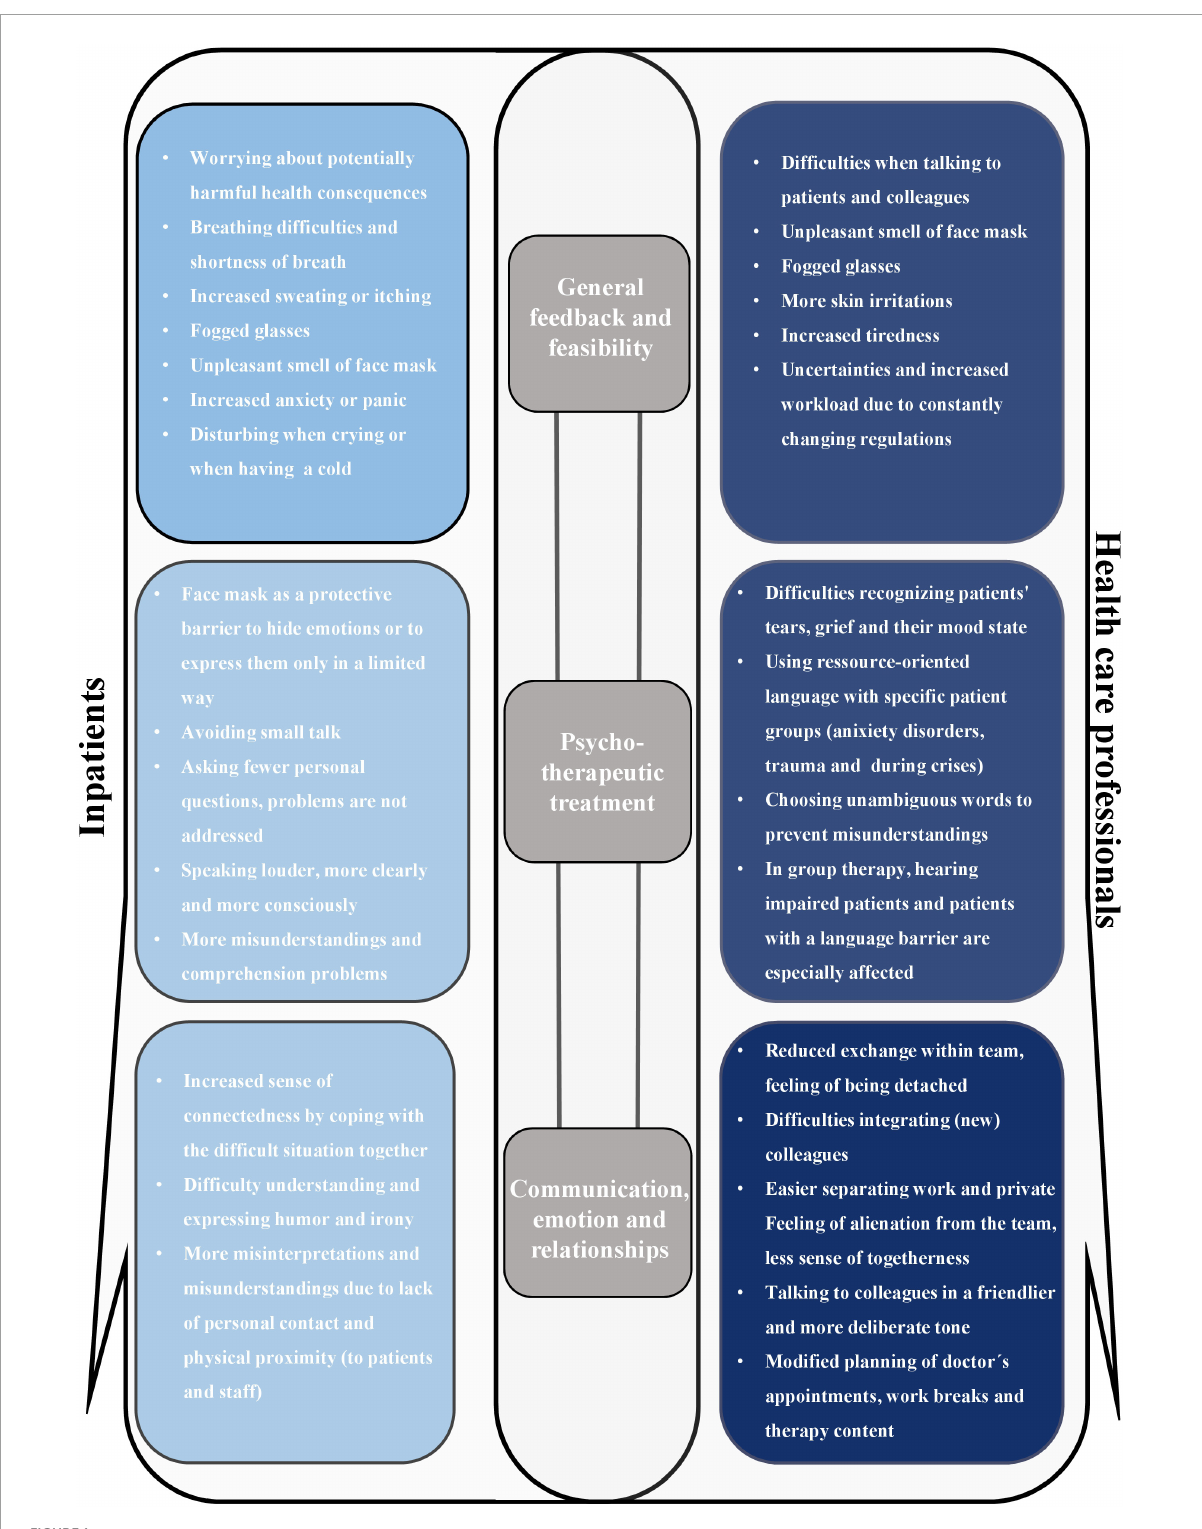
FIGURE1 Visualization of the qualitative results in the three dimensions (i) General feedback and feasibility, (ii) Psychotherapeutic treatment, and (iii) Communication, emotion, and relationships with others by healthcare professionals (right) and patients (left) . For each dimension (i–iii), the most frequent statements of the free text fields were